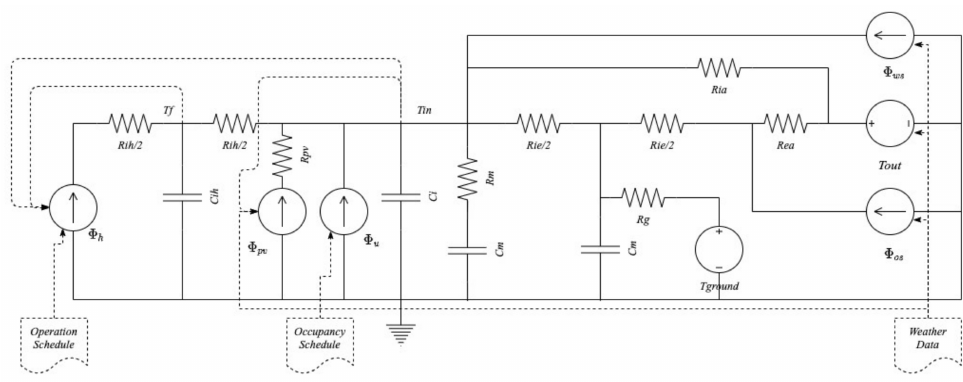
Figure 2. The conceptual diagram of the reduced energy model.